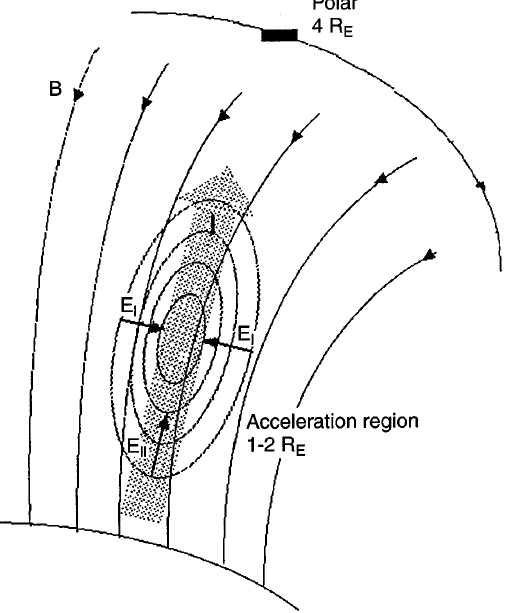
Fig. 10. The O-shaped potential model for auroral electric field. Our data support the O-shaped model rather than the upward extended U-shaped model displayed in Fig. 1. In the O-shaped potential model there need not be any strong electric fields at 4 R Polar altitude even E though simultaneous low-altitude observations would show electro- static shocks and parallel potential drops. We found support for this configuration in 26%